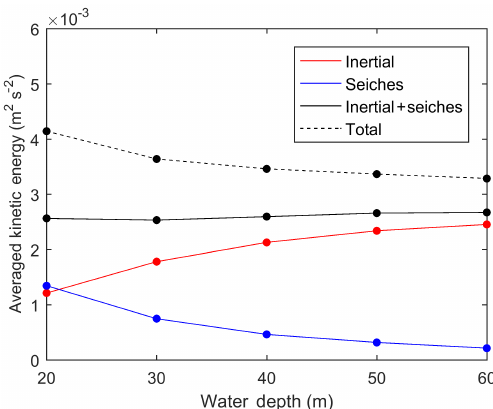
Figure 12. The kinetic energy of near-inertial motions and seiches for different water depths. For each case, the currents are band-pass filtered to get currents for each type of motion which are then aver- aged over time and integrated over space to obtain a final